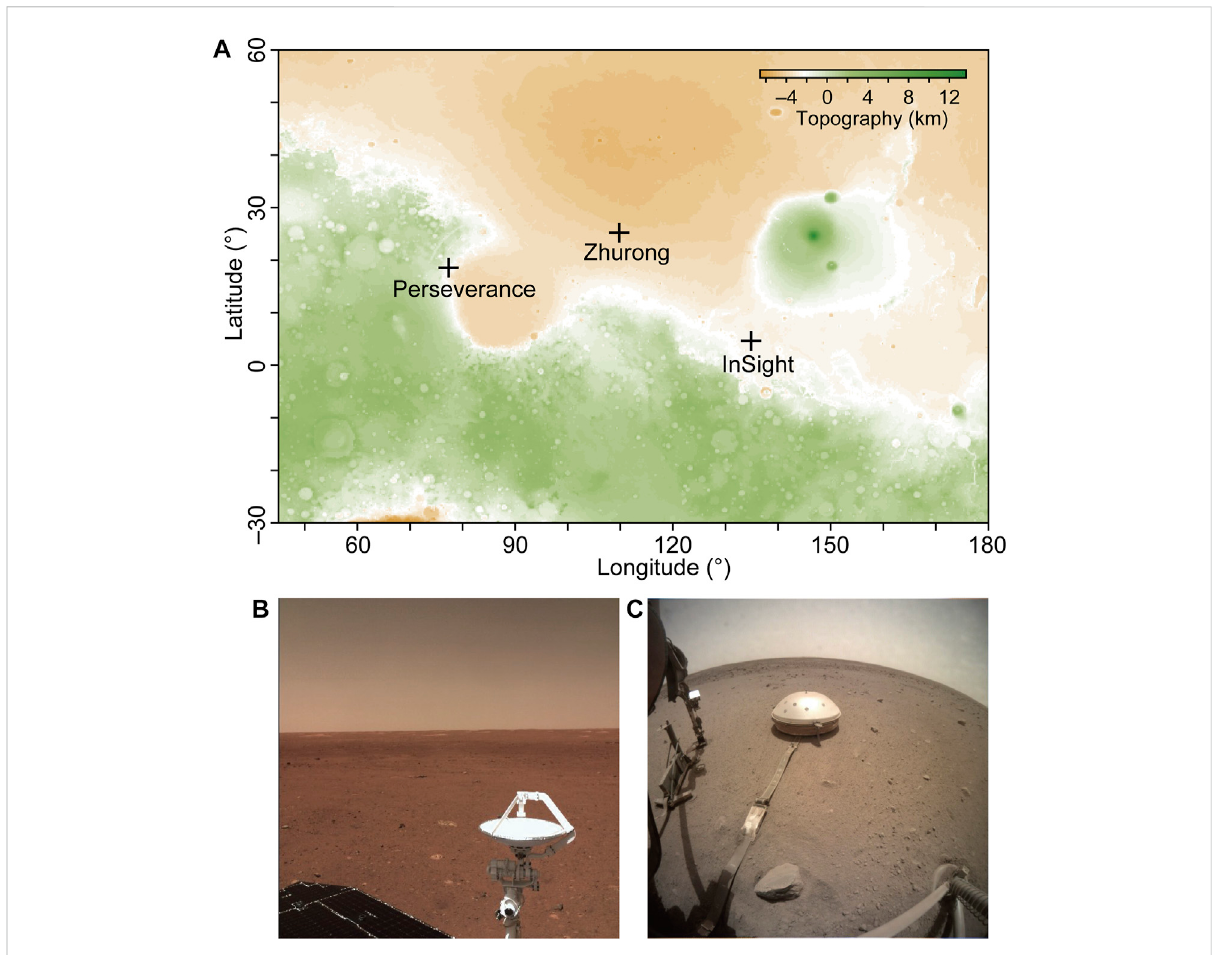
FIGURE 1 The locations of Zhurong rover, InSight lander, and Perseverance lander. (A) the topography around southern Utopia Planitia. (B) Surface view taken by navigation and terrain cameras on Zhurong rover (NaTeCam, Liang et al., 2021; Liu et al., 2021). (C) Surface view taken by InSight lander